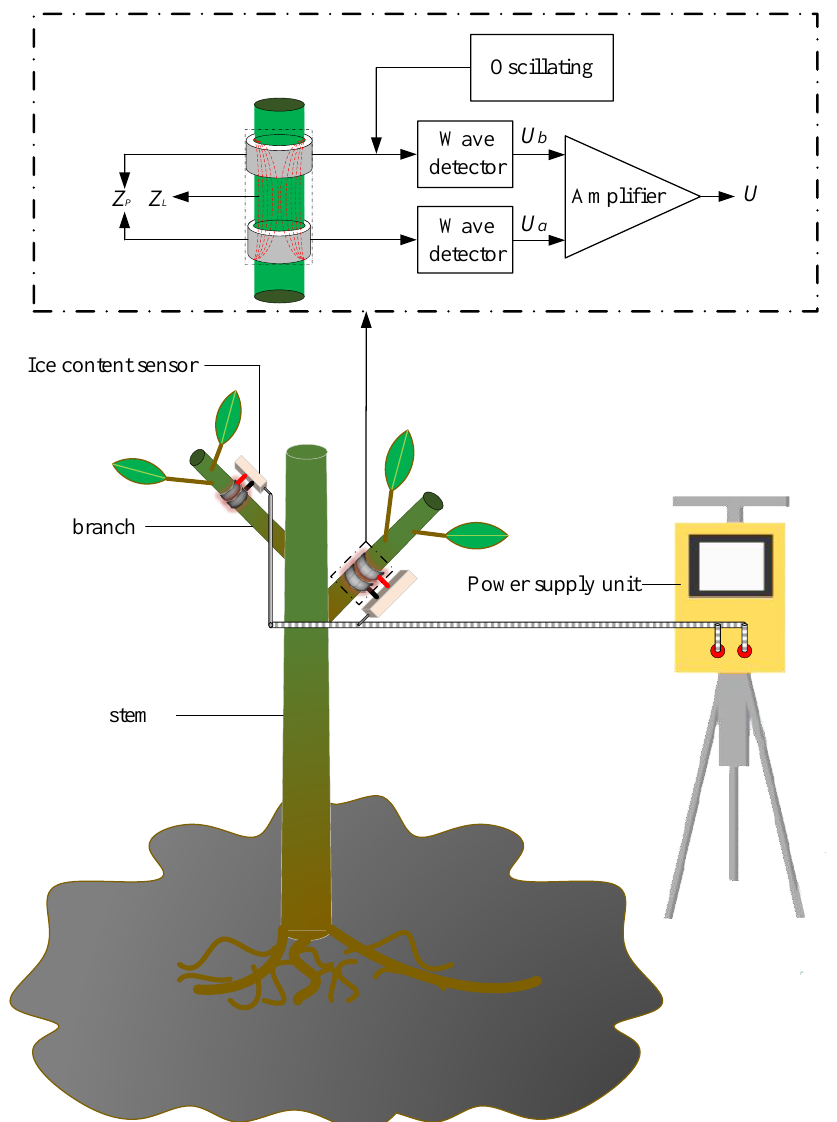
Figure 3. A schematic diagram of the measurement principle of the branch tissue impedance detection based on edge EMF induction.